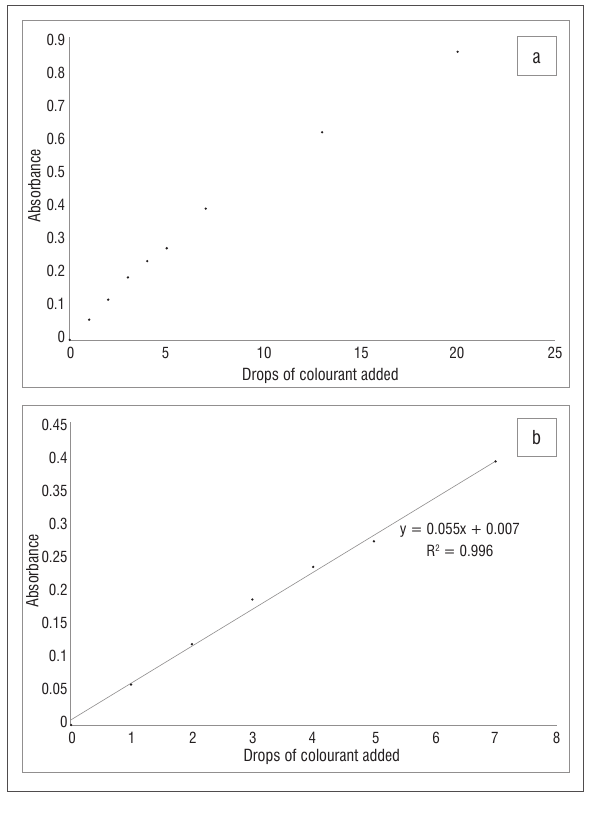
Figure 6: Absorbance values obtained for aqueous solutions of green food colourant using a red LED and the SpecUP in Mode 1: (a) linear and non-linear regions and (b) linear response obtained for lower colourant concentrations.